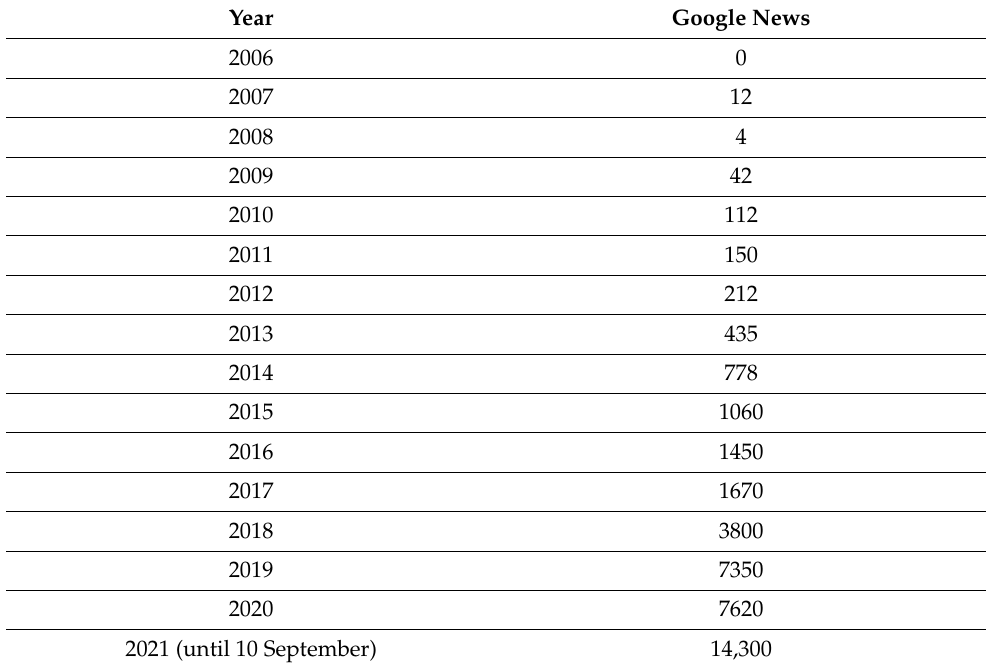
Table 1. Annual frequency of “love jihad” on news sites searchable on Google